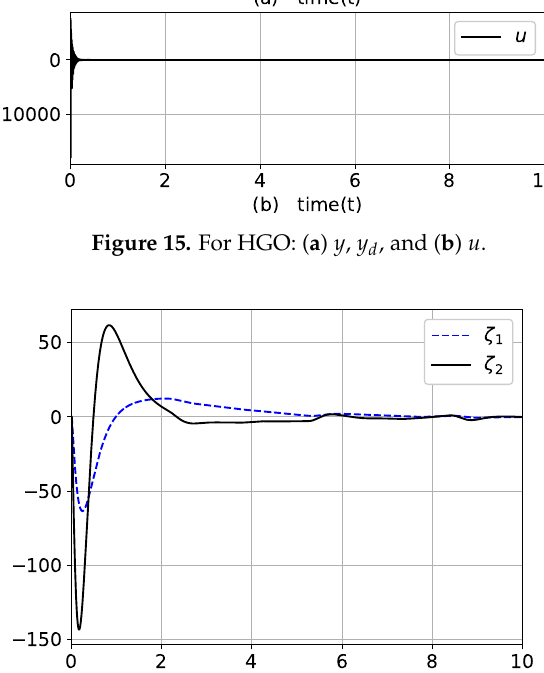
Figure 16. For HGO: trajectories of σ 1 and σ 2 .